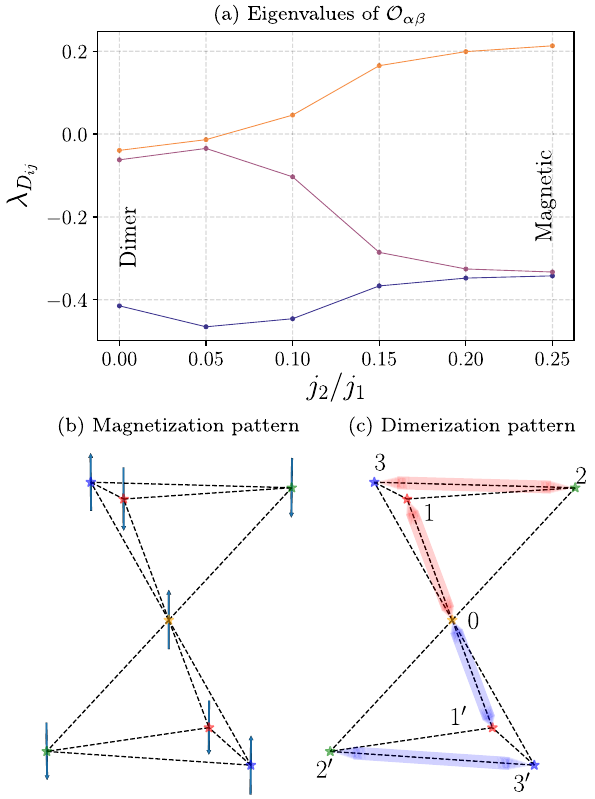
FIG. 10. (a) Eigenvalues of the O αβ operator as a function of j =j λ ¼ 1 . The “ dimer ” and “ magnetic ” labels denote the 2 1 at regions where the behavior is well described with dimer and magnetic fixed point wave functions, respectively. (b) Tetrahedron unit cell showing one of the six classical magnetic k ¼ 0 states ordered in each sublattice. Sublattices are shown in different colors. (c) Tetrahedron unit cell showing one of the three dimerization patterns. Red and blue colors represent two patterns related by inversion